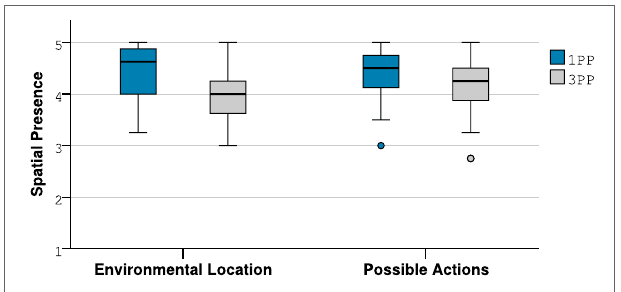
FigUre 7 | Boxplot of the averages of the EL and PA factors of the spatial presence